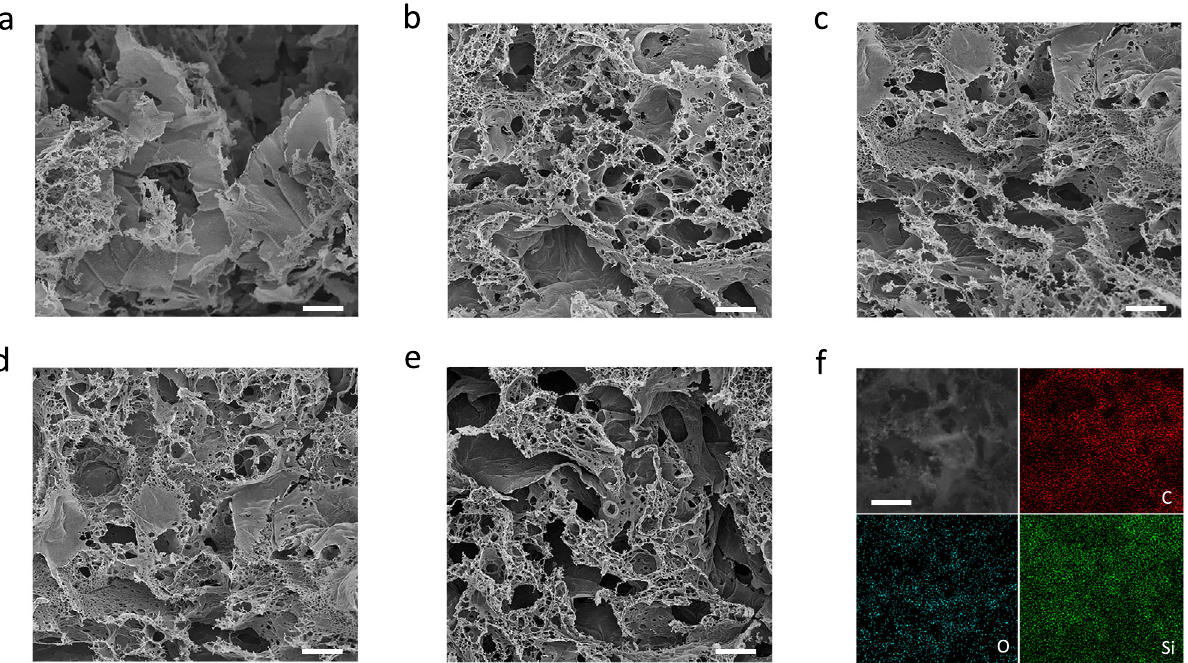
Fig. 2 Morphology characterization of LIG with various laser powers and scanning rates. a – c SEM images of LIG prepared by different laser scan speeds (80, 27, and 16cm s ‒ 1 ) with a laser power of 2.5 W. d , e SEM images of LIG prepared with different laser power (2.2 and 2.8 W) with a